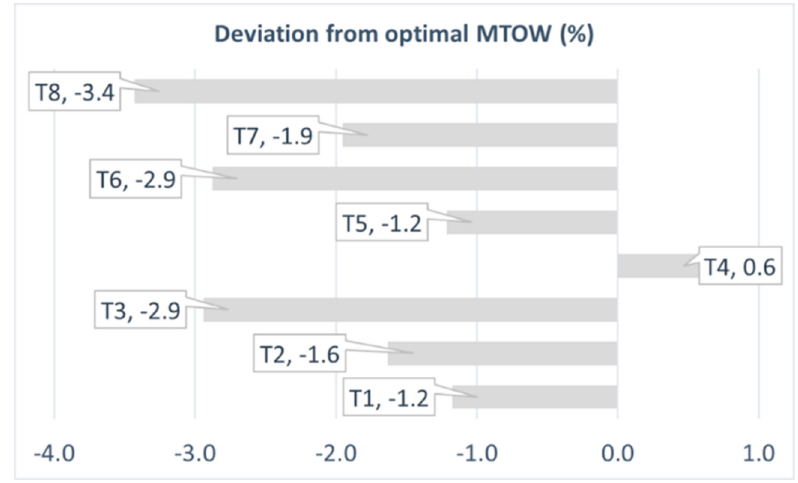
Figure 9. Technology sensitivity analysis: deviation from optimal MTOW target value.